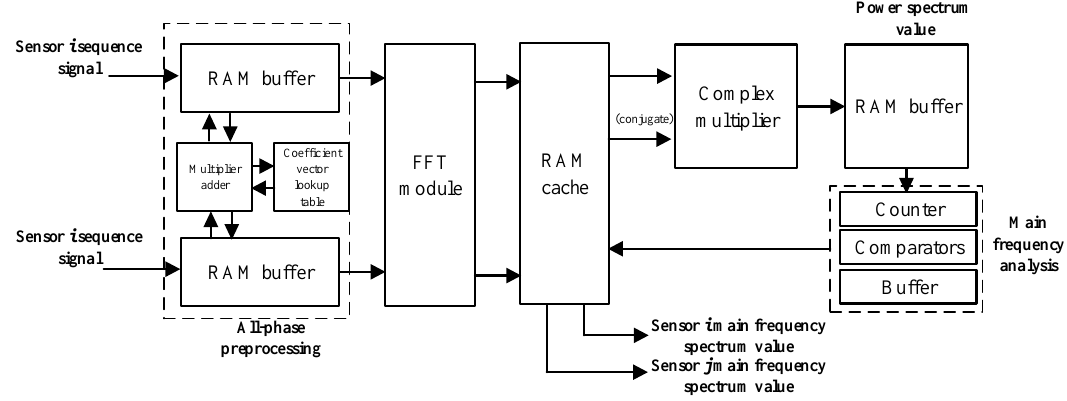
Figure 9. Master frequency measurement circuit block diagram.